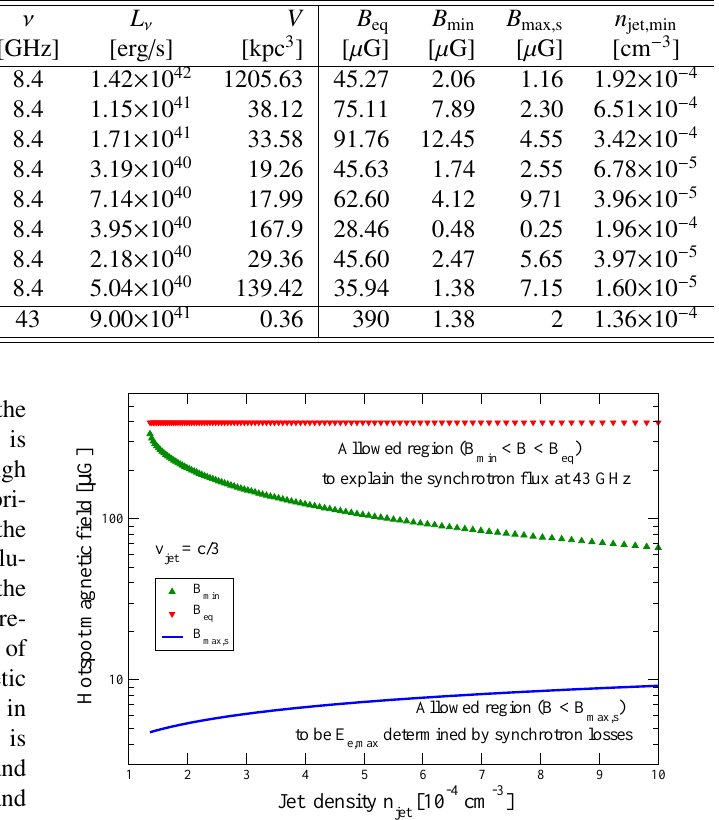
Figure 4. Comparison between the magnetic field required to explain the synchrotron flux at 43 GHz ( B min ≤ B ≤ B eq )